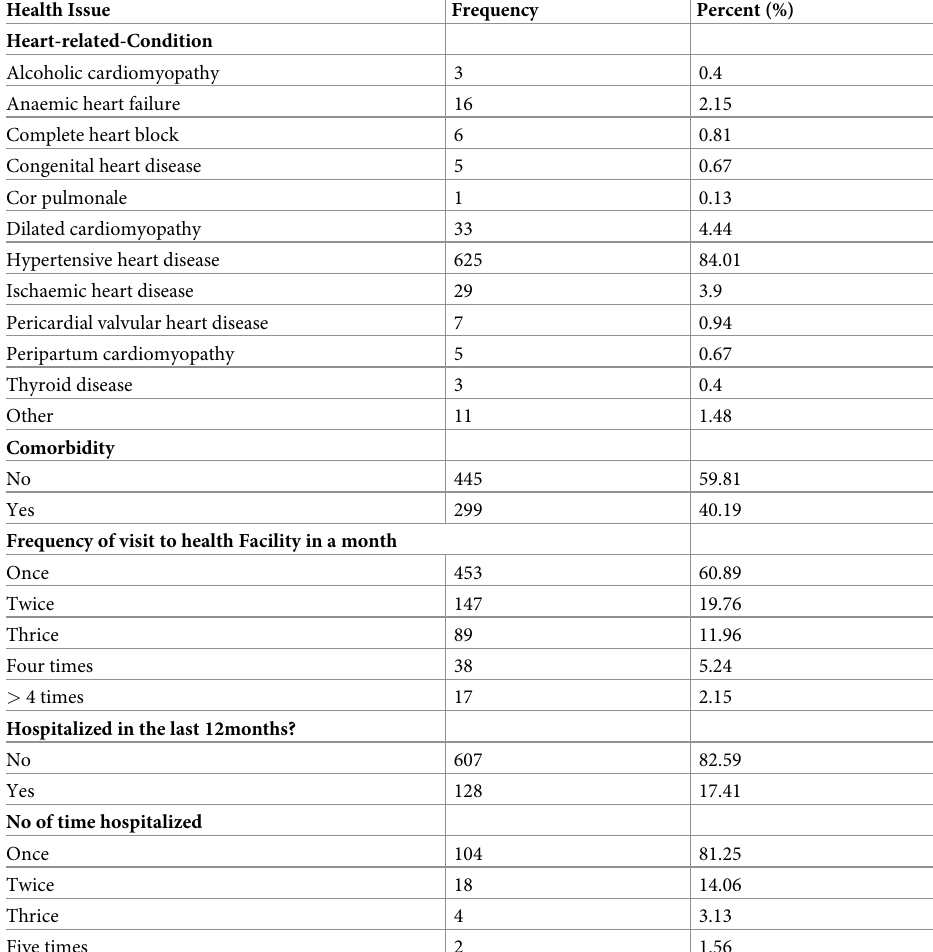
Table 2. Clinical characteristics of CVDs patients accessing healthcare in public and private hospitals in Ibadan (N =